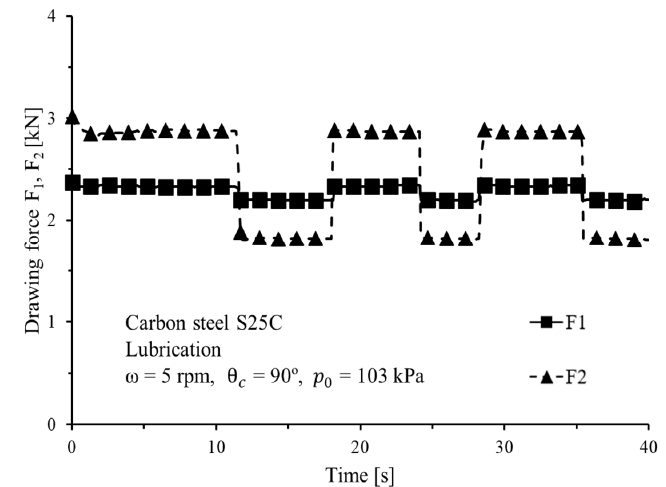
Figure 5. Drawing force variations with rotation speed of 5 rpm.